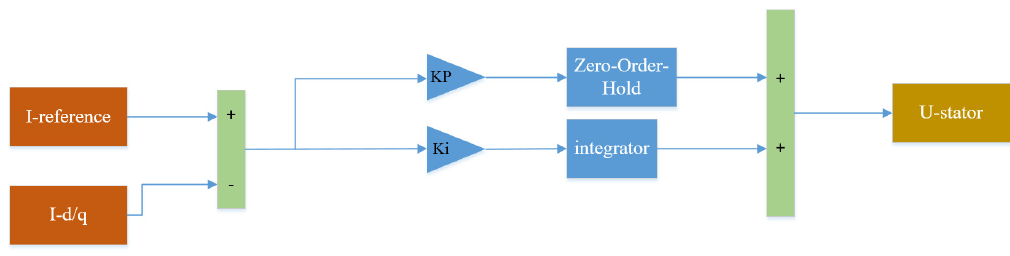
Figure 4. PI speed loop speed control structure.